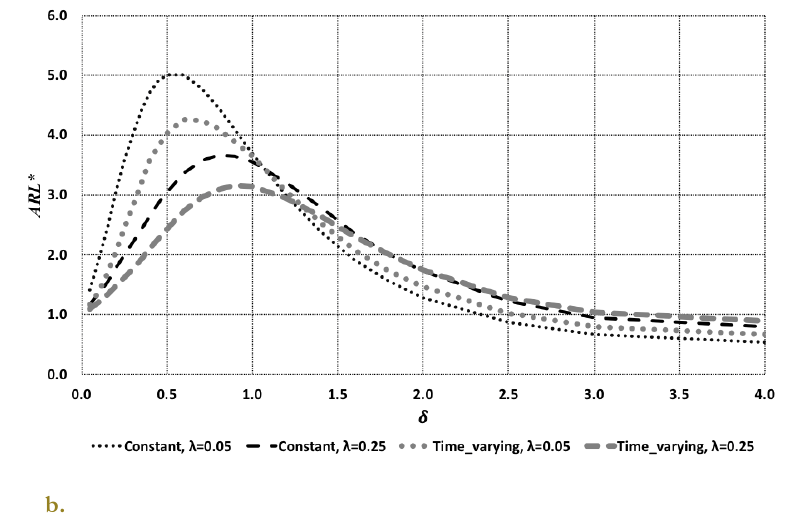
Fig. 4. Steady state 𝐀𝐑𝐋 ∗ profiles for; a. 𝐀 = 𝟎 , b. 𝐀 = −𝟎. 𝟐 .